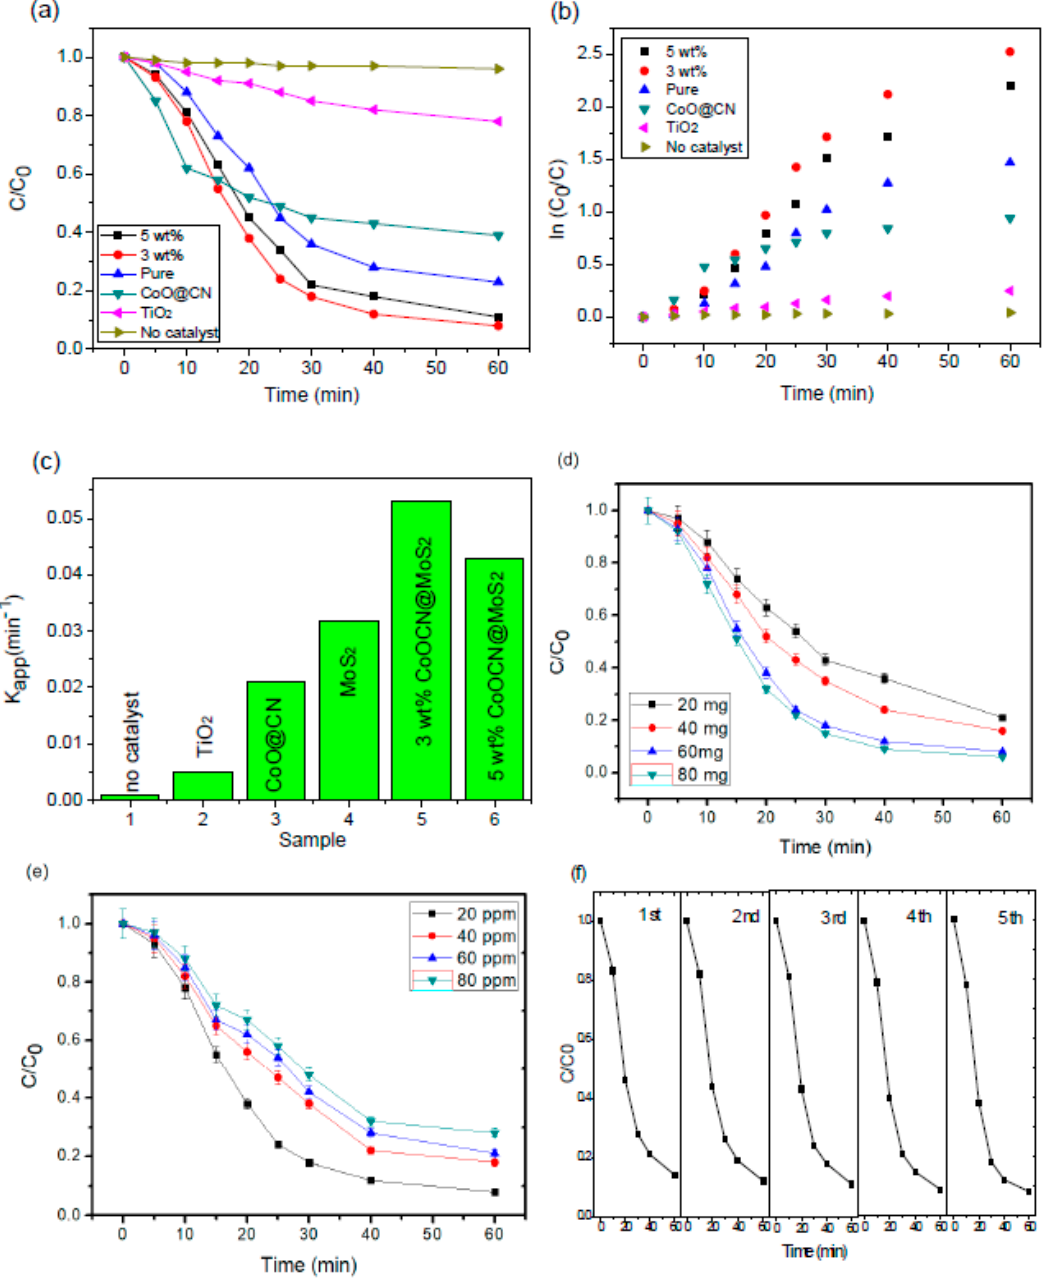
Figure 6. Photocatalytic activity of CoO@meso–CN@MoS 2 heterostructure materials towards